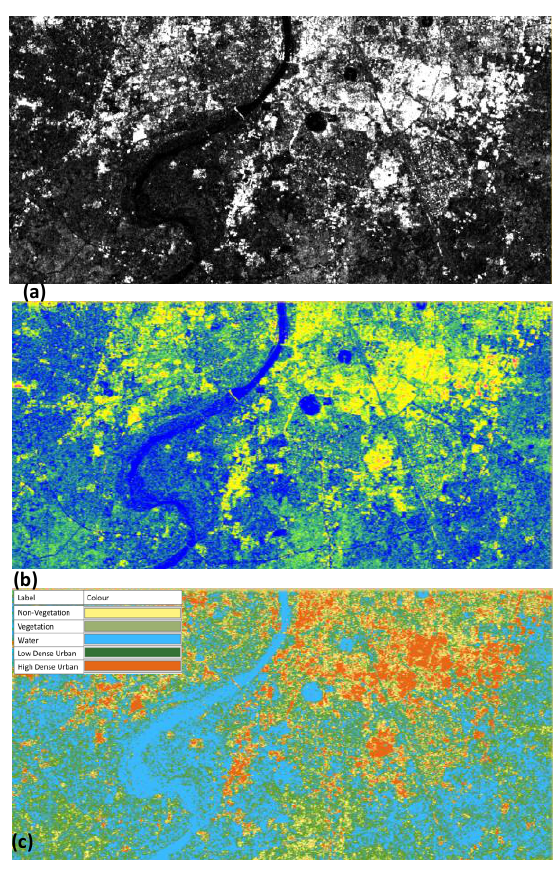
Figure 4. (a) HH polarization data (b) FCC of textures (Mean, Entropy and Homogeneity) generated from (a) and (c) Classified map of (b)